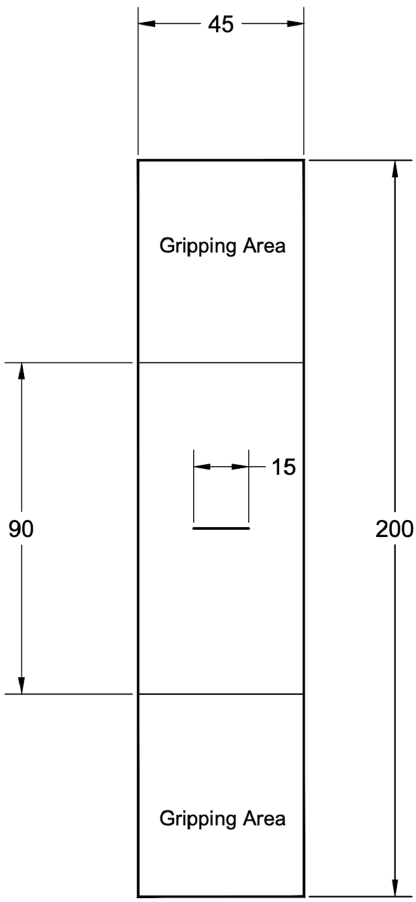
Figure 8. Center-cracked tension (CCT) specimen geometry (dimensions in mm) [32].